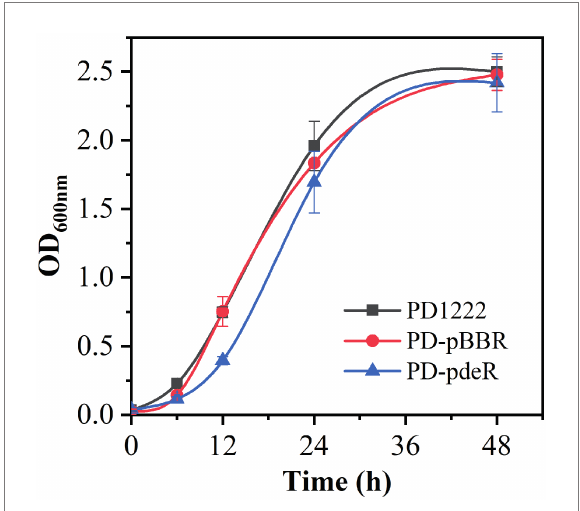
FIGURE 1 The growth curve of PD1222, PD-pdeR and PD-pBBR. Black, PD122; red, PD-pBBR; blue, PD-pdeR. Data are presented as mean ± SD, n = 3.